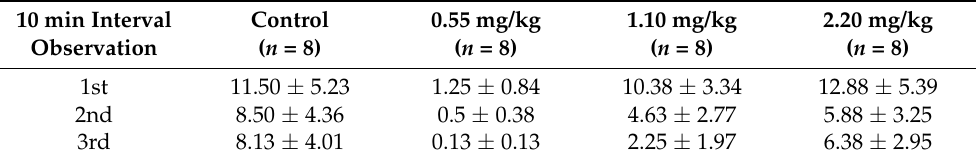
Table 4. Mount frequency of male rats treated with M. oleifera leaf tea and the control group observed in three 10 min interval over 30 min period.